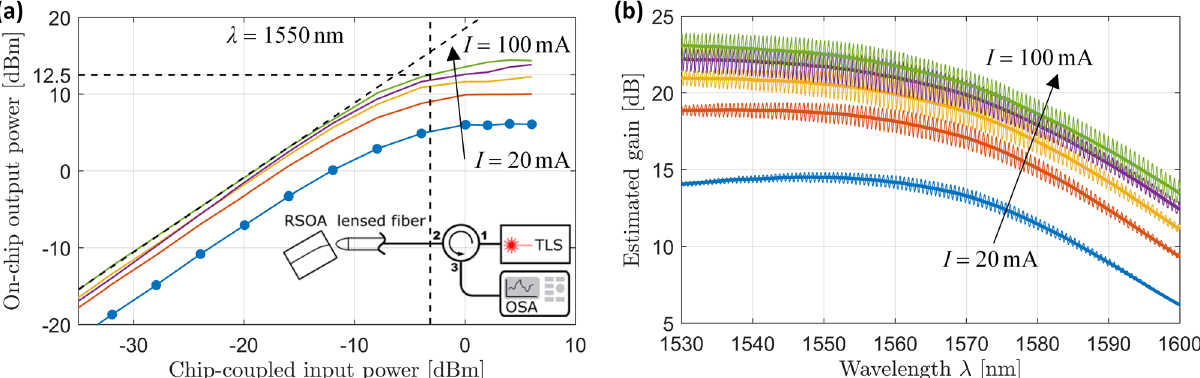
Figure 2. RSOA characterization. ( a ) Typical on-chip output power vs. chip-coupled input power for various injection currents I . In the experiment, the device was tested with 12 discrete input power levels—for the sake of readability, the corresponding measurement points are indicated for the curve I = 20 mA only. At a bias current of 100 mA, the saturation output power, defined by a 3 dB gain compression, amounts to 12.5 dBm. Inset: Simplified sketch of the underlying experimental setup, consisting of a tunable laser source (TLS), an optical circulator, and an optical spectrum analyzer (OSA). Details of the data evaluation can be found in Supplementary Section 1. ( b ) Typical RSOA gain as a function of wavelength for various injection currents I . The ripples stem from reflections at the facets of the 600 µm-long RSOA waveguide and have a periodicity of 73 GHz. Note that the ripple height does not only depend on the gain, but also exhibits a wavelength dependence. We attribute this to the residual reflectivity of the anti-reflection (AR) coating on the front